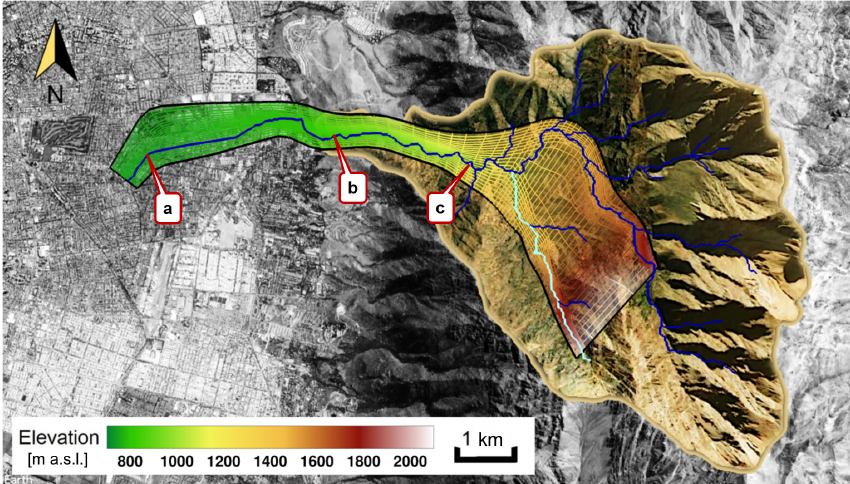
Figure 1. Satellite image of the Quebrada de Ramón watershed and the computational domain. The area enclosed by the black line is defined from the lidar topography and incorporates the section of the city around the river channel. The main channel is depicted in blue and the tributary in turquoise. Background image of the terrain from © Google Earth.